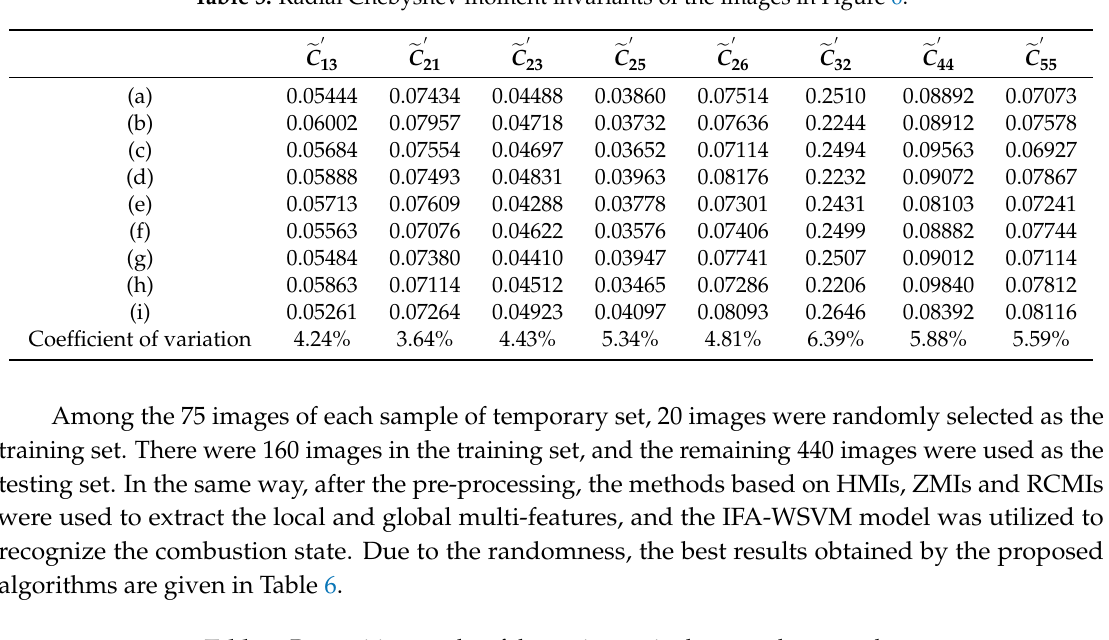
Table 6. Recognition results of the testing set in the second case